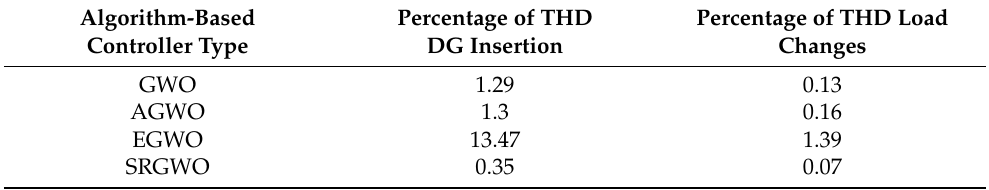
Table 7. The output current THD for GWO, AGWO, EGWO and SRGWO algorithm-based controllers.